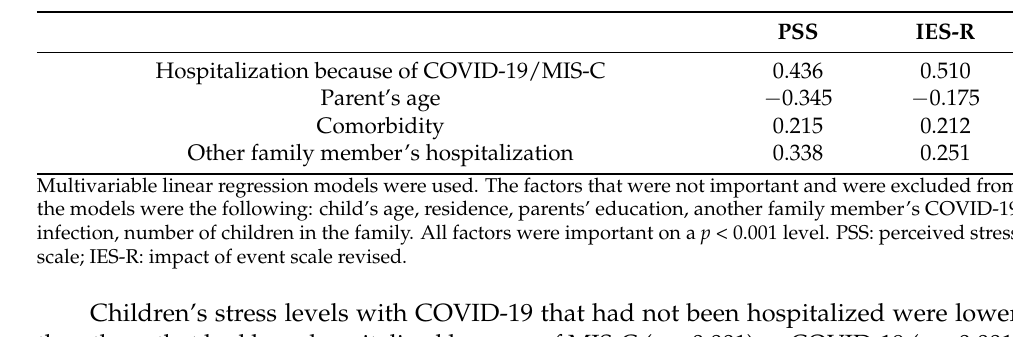
Table 3. Multivariable linear regression on factors that affect PSS and IES-R scales. Hospitalization because of COVID-19/MIS-C